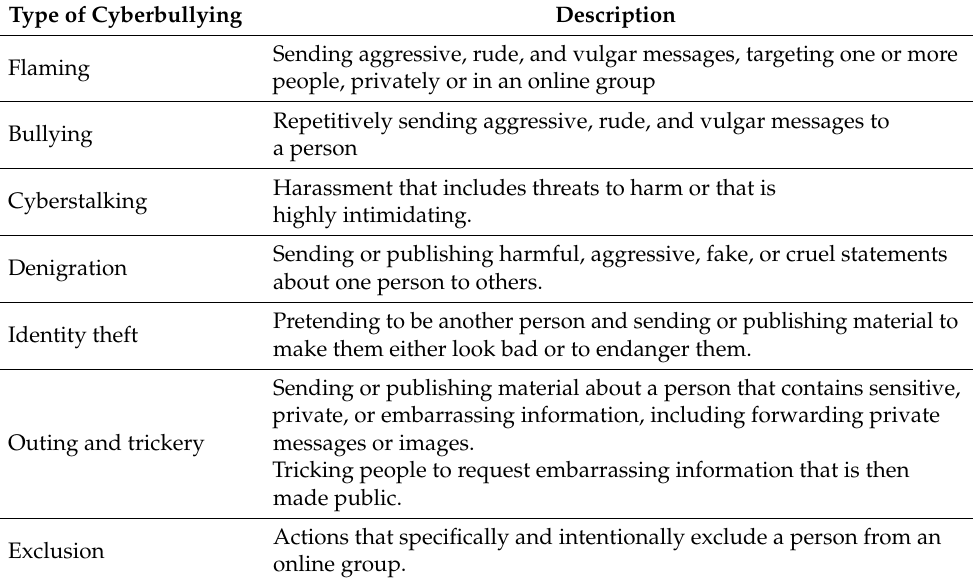
Table 1. Types of cyberbullying